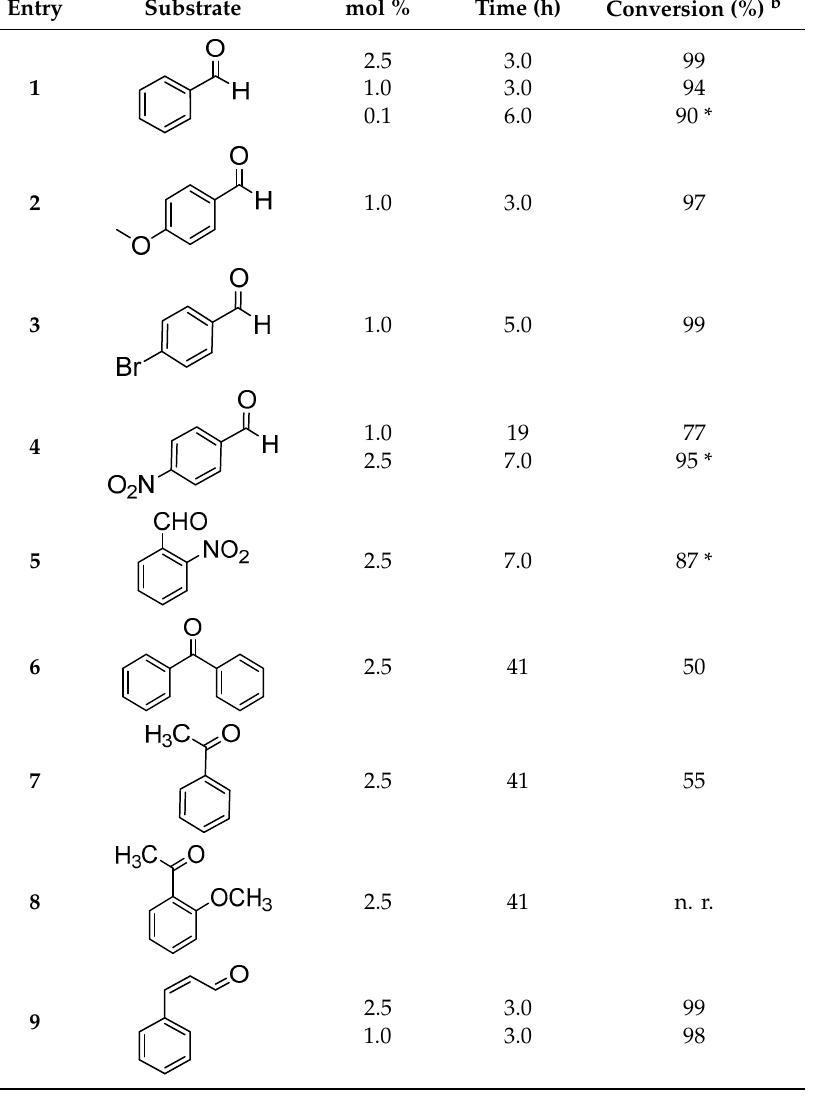
Table 2. Hydrosilylation of aldehydes and ketones catalyzed by 2b with PhSiH 3a .